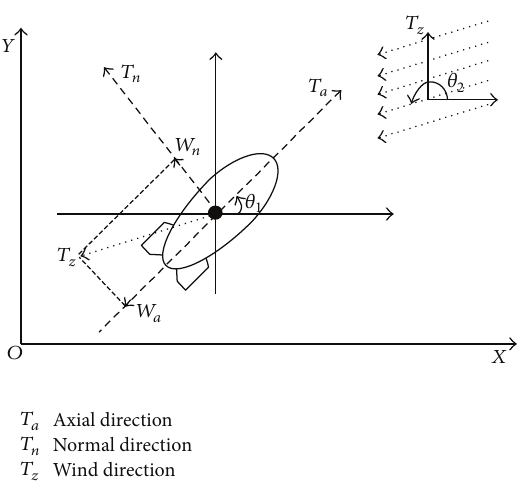
Figure 2: The plane motion of high-altitude